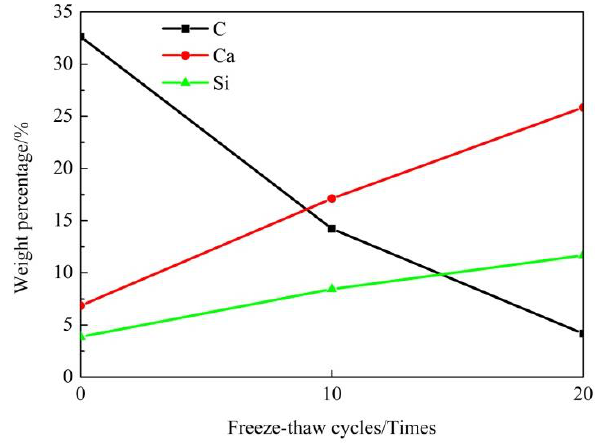
Figure 10. Chemical composition of mortar in different freeze–thaw cycles with the complete water saturation condition.